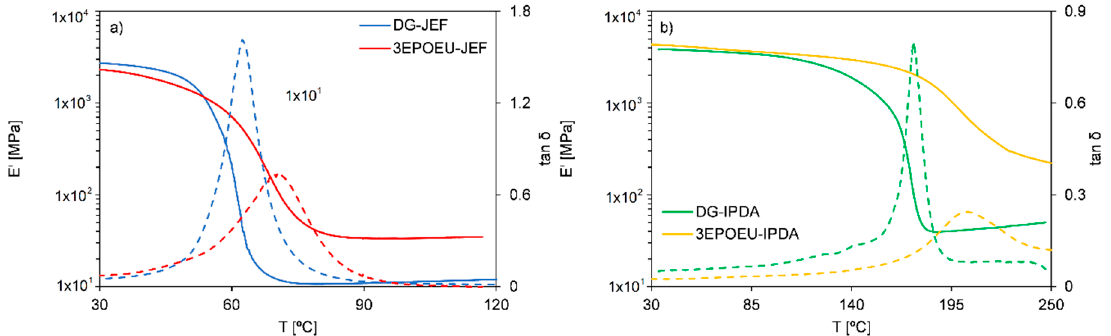
Figure 4. E (cid:48) and tan δ curves of the formulations cross-linked with Je ff amine ® D-400 ( a ) and isophorone Figure 4. E ′ and tan δ curves of the formulations cross-linked with Jeffamine ® D-400 ( a ) and isophorone diamine (IPDA) ( b diamine (IPDA) ( b ).